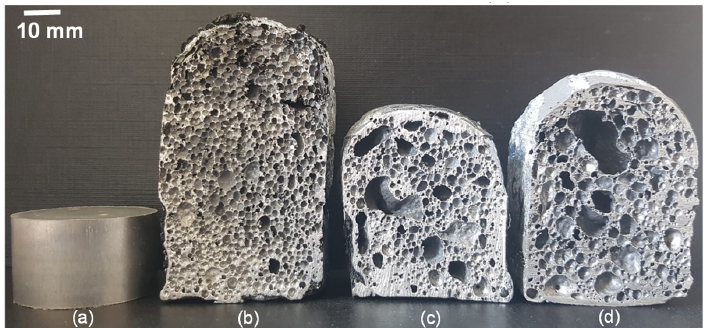
Figure 3. Macrostructure of aluminum foam expansion affected by reinforcement and foaming time of ( a ) Precursor material Multi-wall Carbon Nanotube reinforced AlMg4Si8; ( b ) AlMg4Si8 foam; ( c ) MWCNT coated nickel reinforced AlMg4Si8 foam for 8 min; ( d ) MWCNT coated nickel reinforced AlMg4Si8 foam for 9 min. (TU Ilmenau; FG MWV).